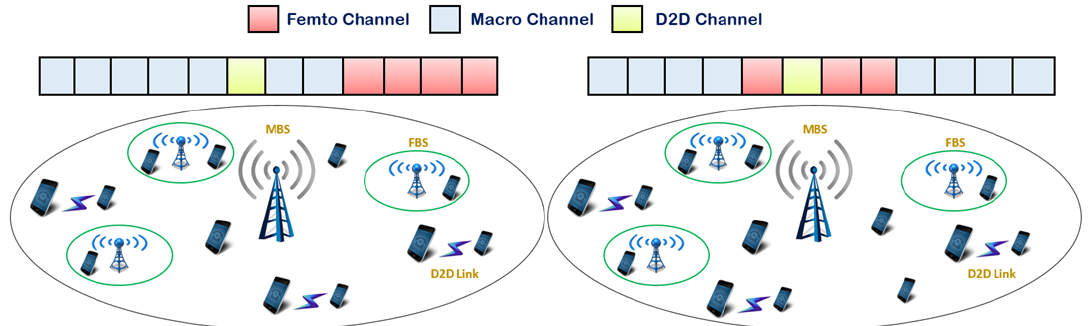
Figure 1. System model: a multi-cell network topology for a D2D-enabled two-tier cellular network composed of a macrocell tier overlaid with a femtocell tier.